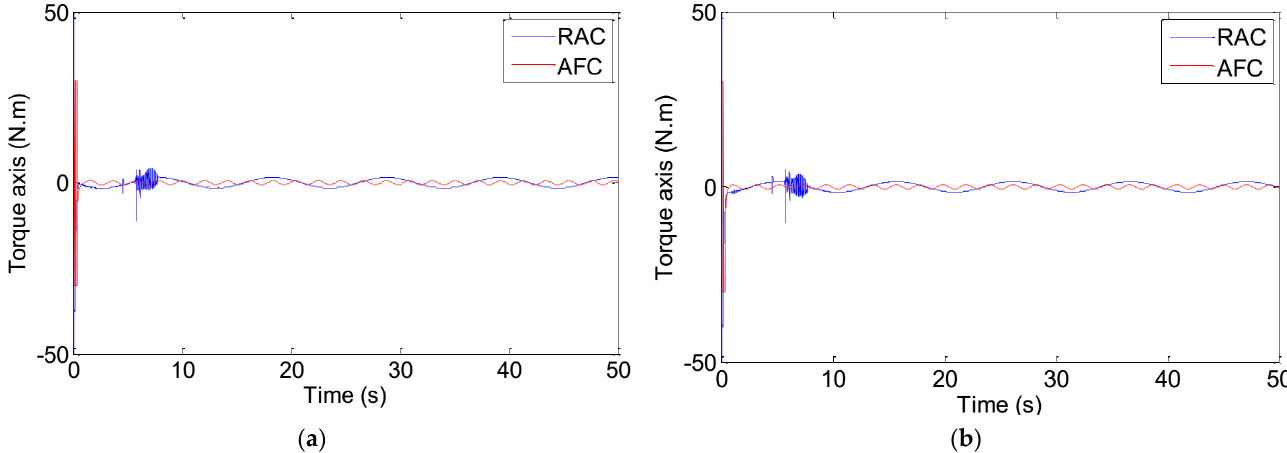
Figure 6. The magnitude of robot velocity error based on AFC and RAC.